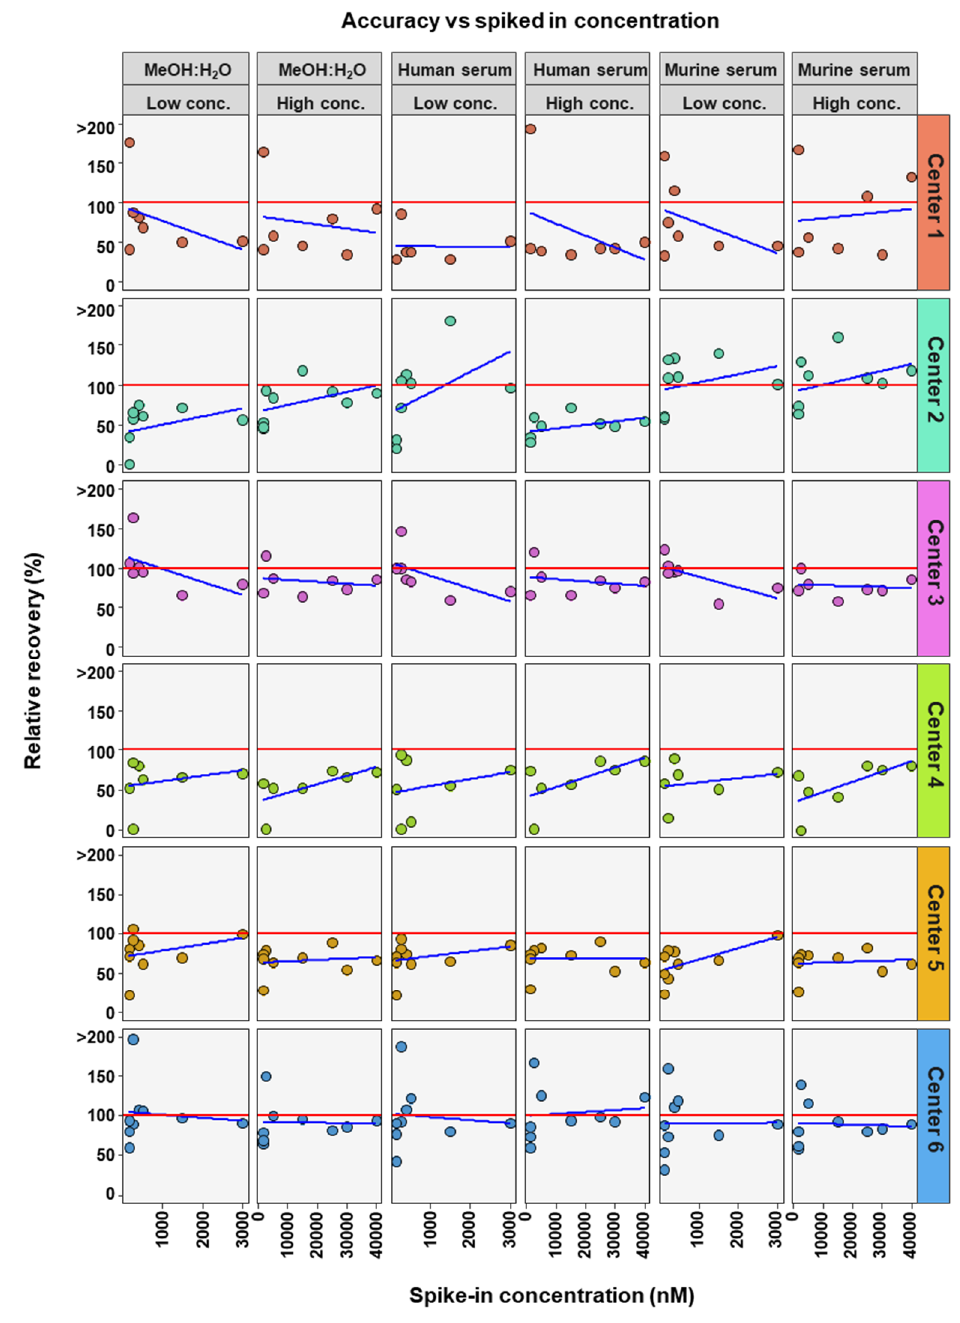
Figure 5. Comparison of spiked concentration of bile acids to accuracy of measurements for each assessing center.